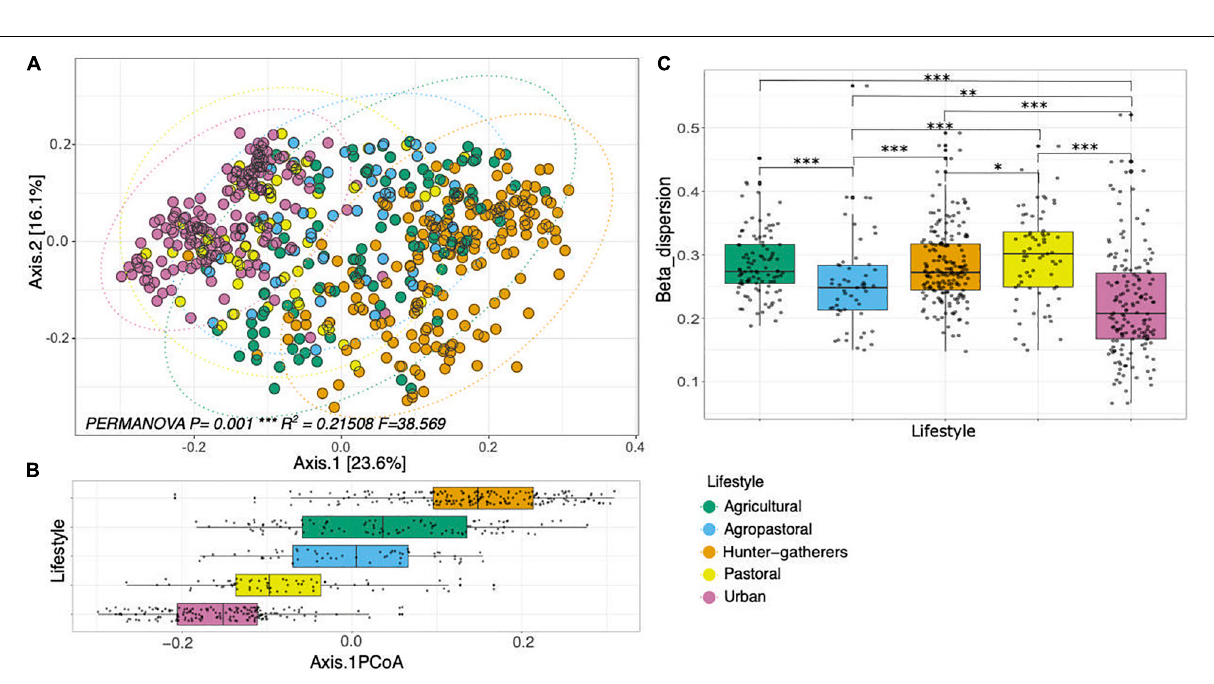
Frontiers in Microbiology |